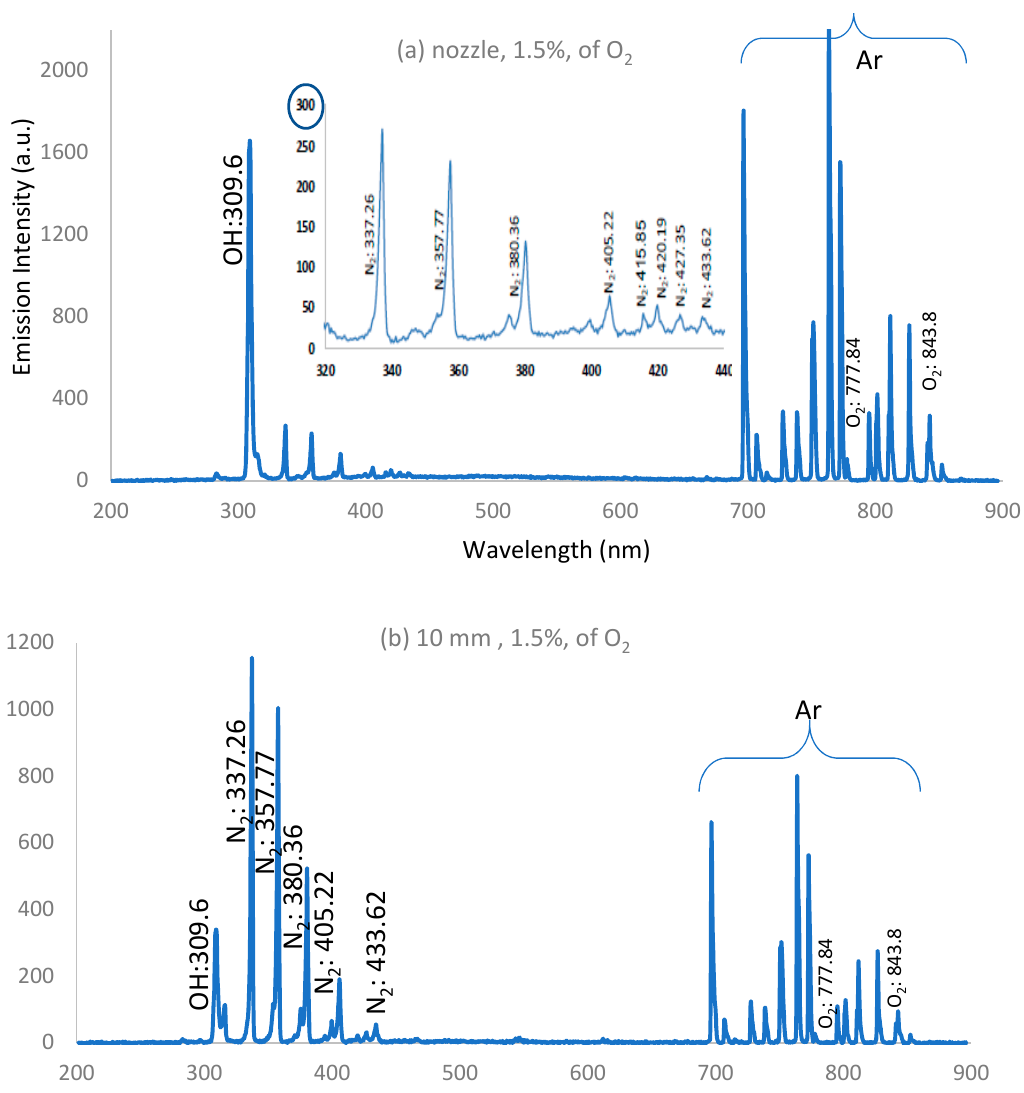
Figure 14. Optical emission spectra of APPJ using oxygen/argon admixture discharge at an applied flow rate of 1.5% of O 2 for ( a ) nozzle and ( b ) 10 mm.